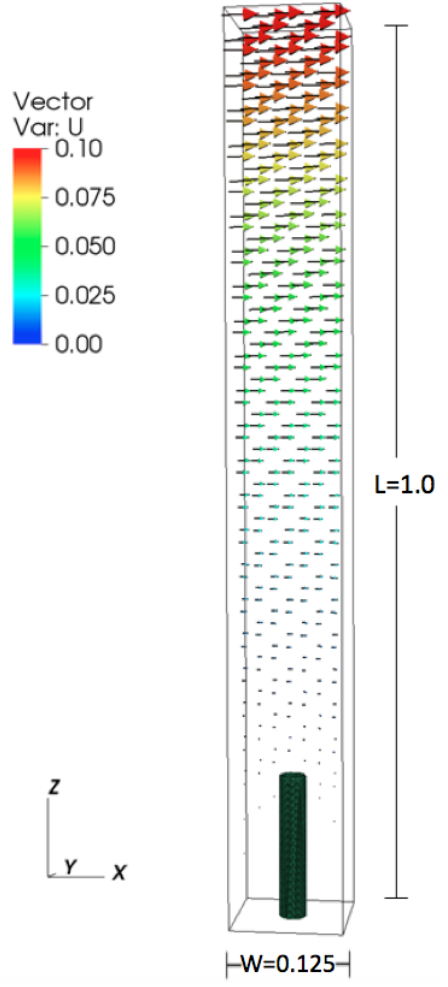
Figure 1. Numerical set up for the periodic cylinder